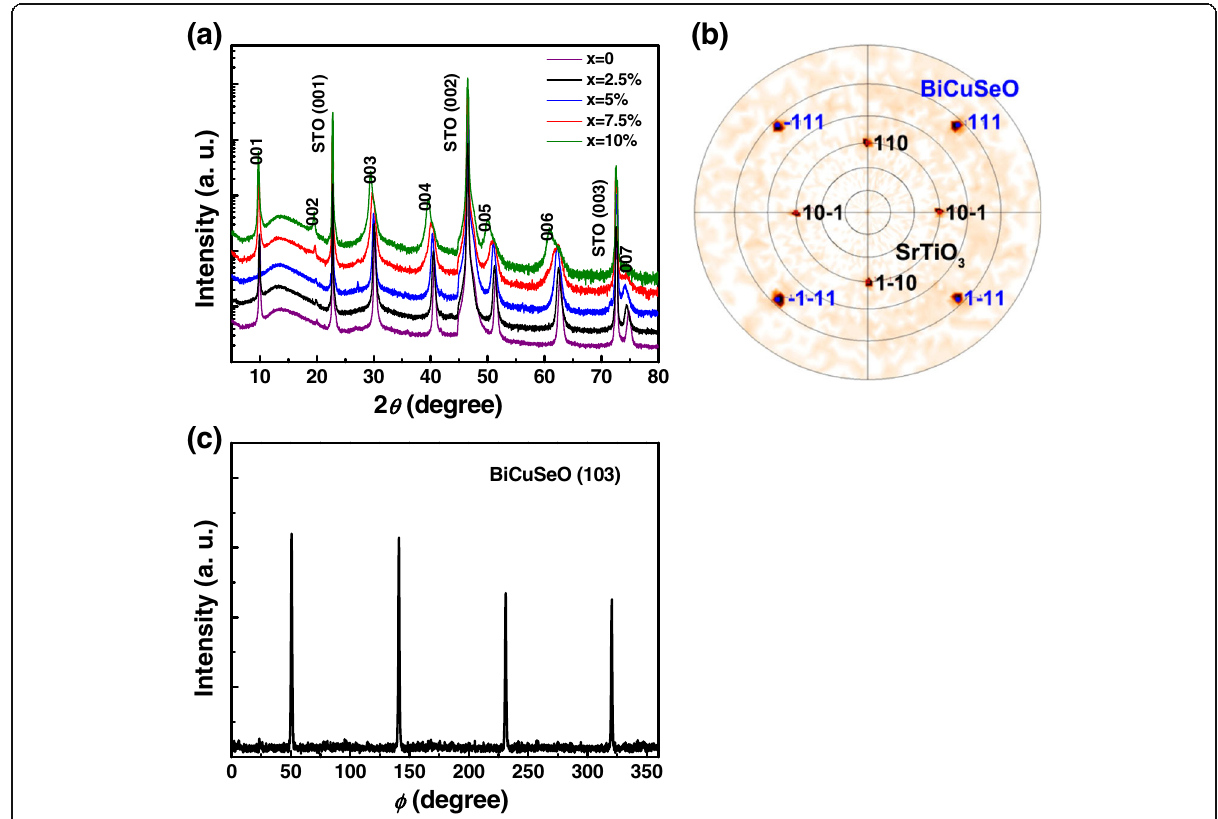
Fig. 1 a XRD θ – 2 θ scans of Bi 1 − x Ba x CuSeO (0 ≤ x ≤ 10%) thin films on the SrTiO 3 (001) substrates. b Pole figure of BiCuSeO (111) and SrTiO 3 (110) recorded at 33.75°. c φ scan of the (103) peak of BiCuSeO thin film